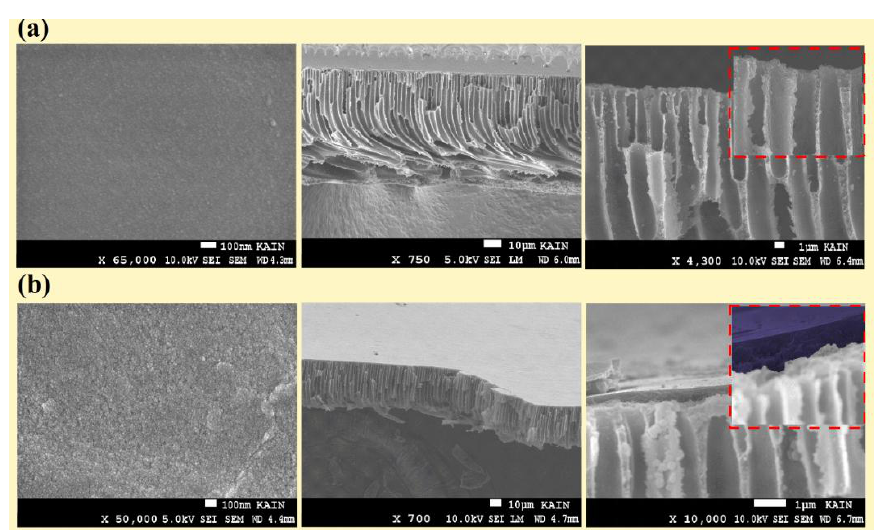
Figure 2. Cross-sectional scanning electron microscope (SEM) images of ( a ) the Poly (phenyl sulfone) (PPSU) support and ( b ) the PANI-coated PPSU membrane.